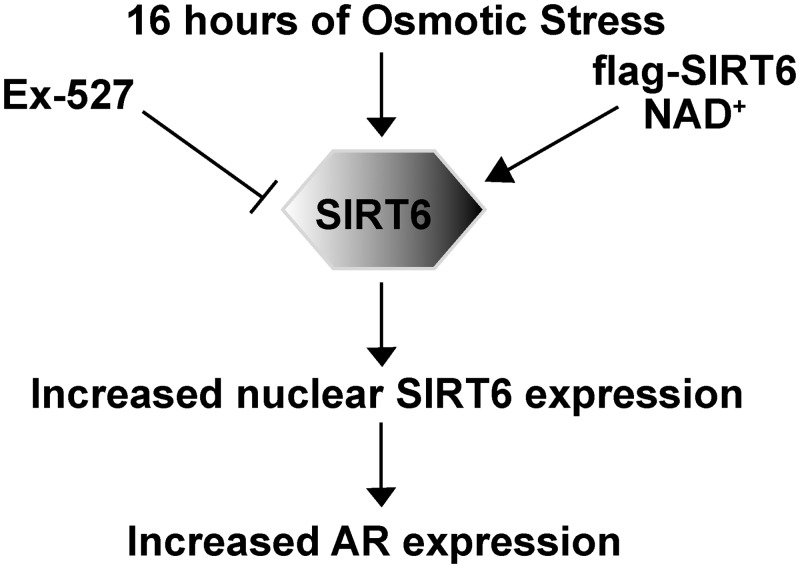
Proposed mechanism for SIRT6 based regulation of AR expression under hyperosmotic environment.